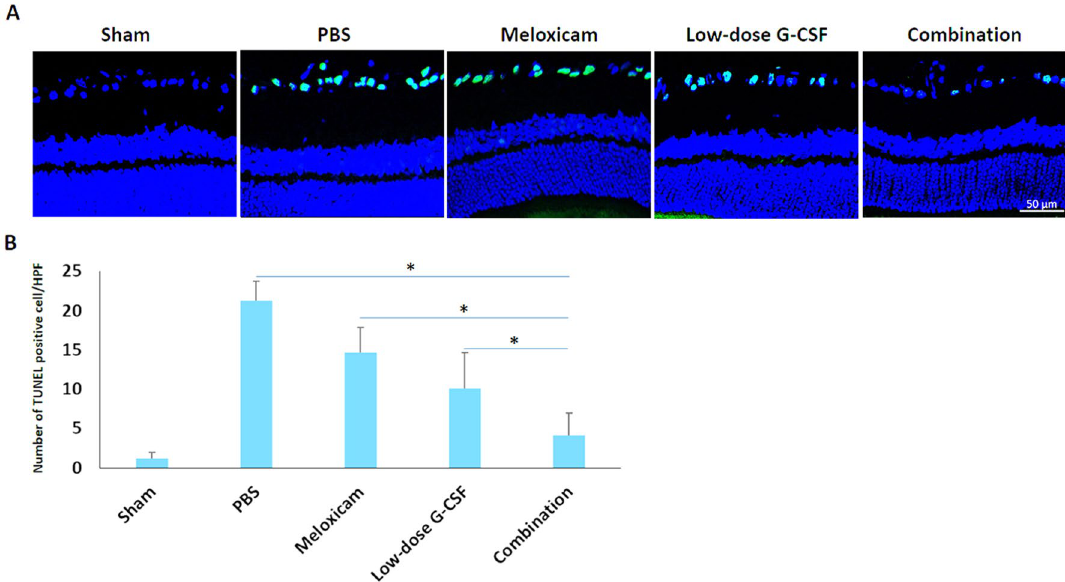
Figure 4. Analysis of RGC apoptosis in the RGC layer through TUNEL assay at four weeks after rAION induction. ( A ) Representative images of double-stained apoptotic cells in the RGC layers in each group. The apoptotic cells (TUNEL-positive cells) in green were stained with TUNEL staining, and the nuclei of the RGCs in blue were labeled with DAPI staining. ( B ) Quantification of TUNEL-positive cells per high-power field. Data are expressed as mean ± SD for each group (n = 6). Treatment with low-dose G-CSF plus meloxicam significantly reduced the number of apoptotic RGC by 3.6- and 2.5-fold compared with the meloxicam-treated and low-dose G-CSF-treated groups, respectively. *p <